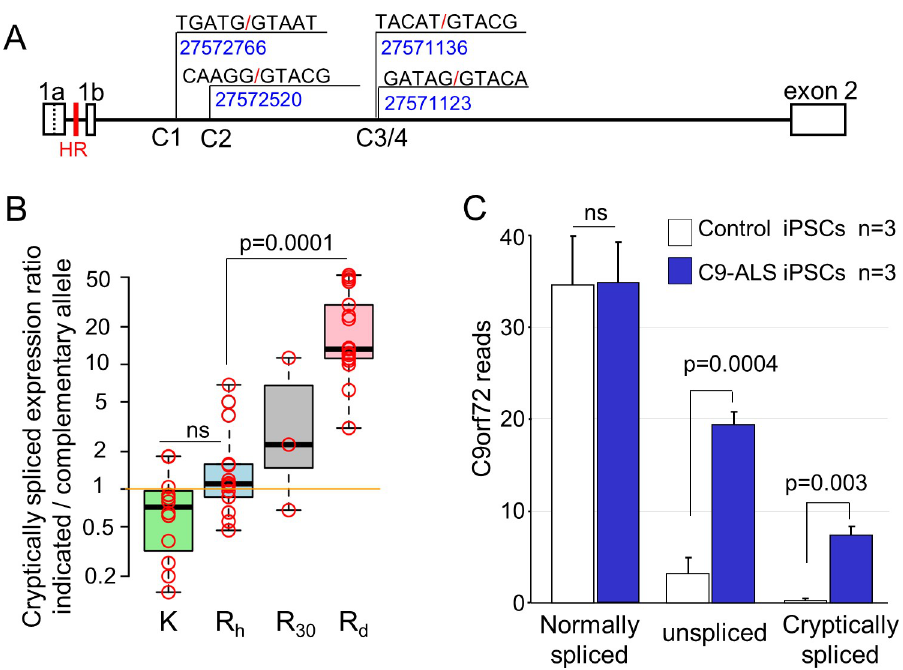
Fig 4. HR expansion activates cryptic donor splice sites in intron 1. (A) Schematic presentation for the location and sequence of intron 1 cryptic donor splice sites C1-C4. (B) Boxplots showing relative allelic usage of cryptic splice-sites (C1-C4) in fibroblasts. K alleles (relative to F, N, P, J, and R h alleles) are in green, R h alleles with 7–16 repeats (relative to K, F, and P alleles) are in blue, the R 30 allele (relative to K allele) is in grey, and the R d alleles (relative to K, F, and N alleles) are in pink. The orange horizontal line delineates a ratio of 1 and represents the expression level of the complementary allele. (C) The expression of normal, unspliced, and cryptically spliced C9orf72 transcripts in control and C9-ALS iPSCs, based on the RNA-seq results. Data are presented as mean ± SEM. ns: non-significant.